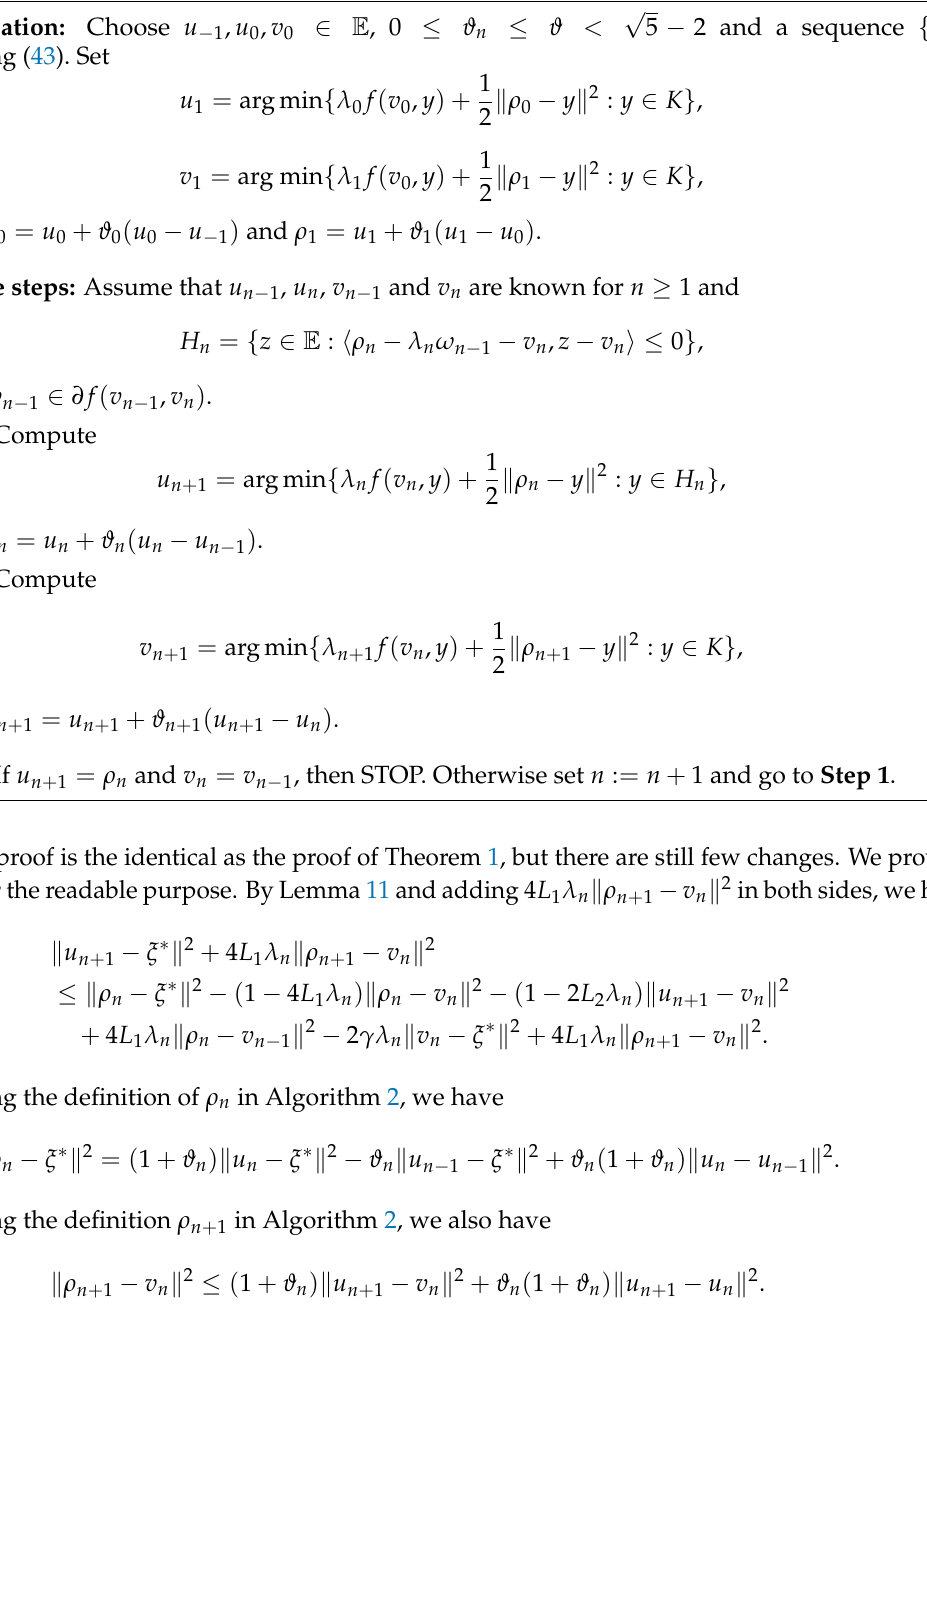
Algorithm 2 (Two-step Subgradient Extragradient Algorithm for Strongly Pseudomonotone